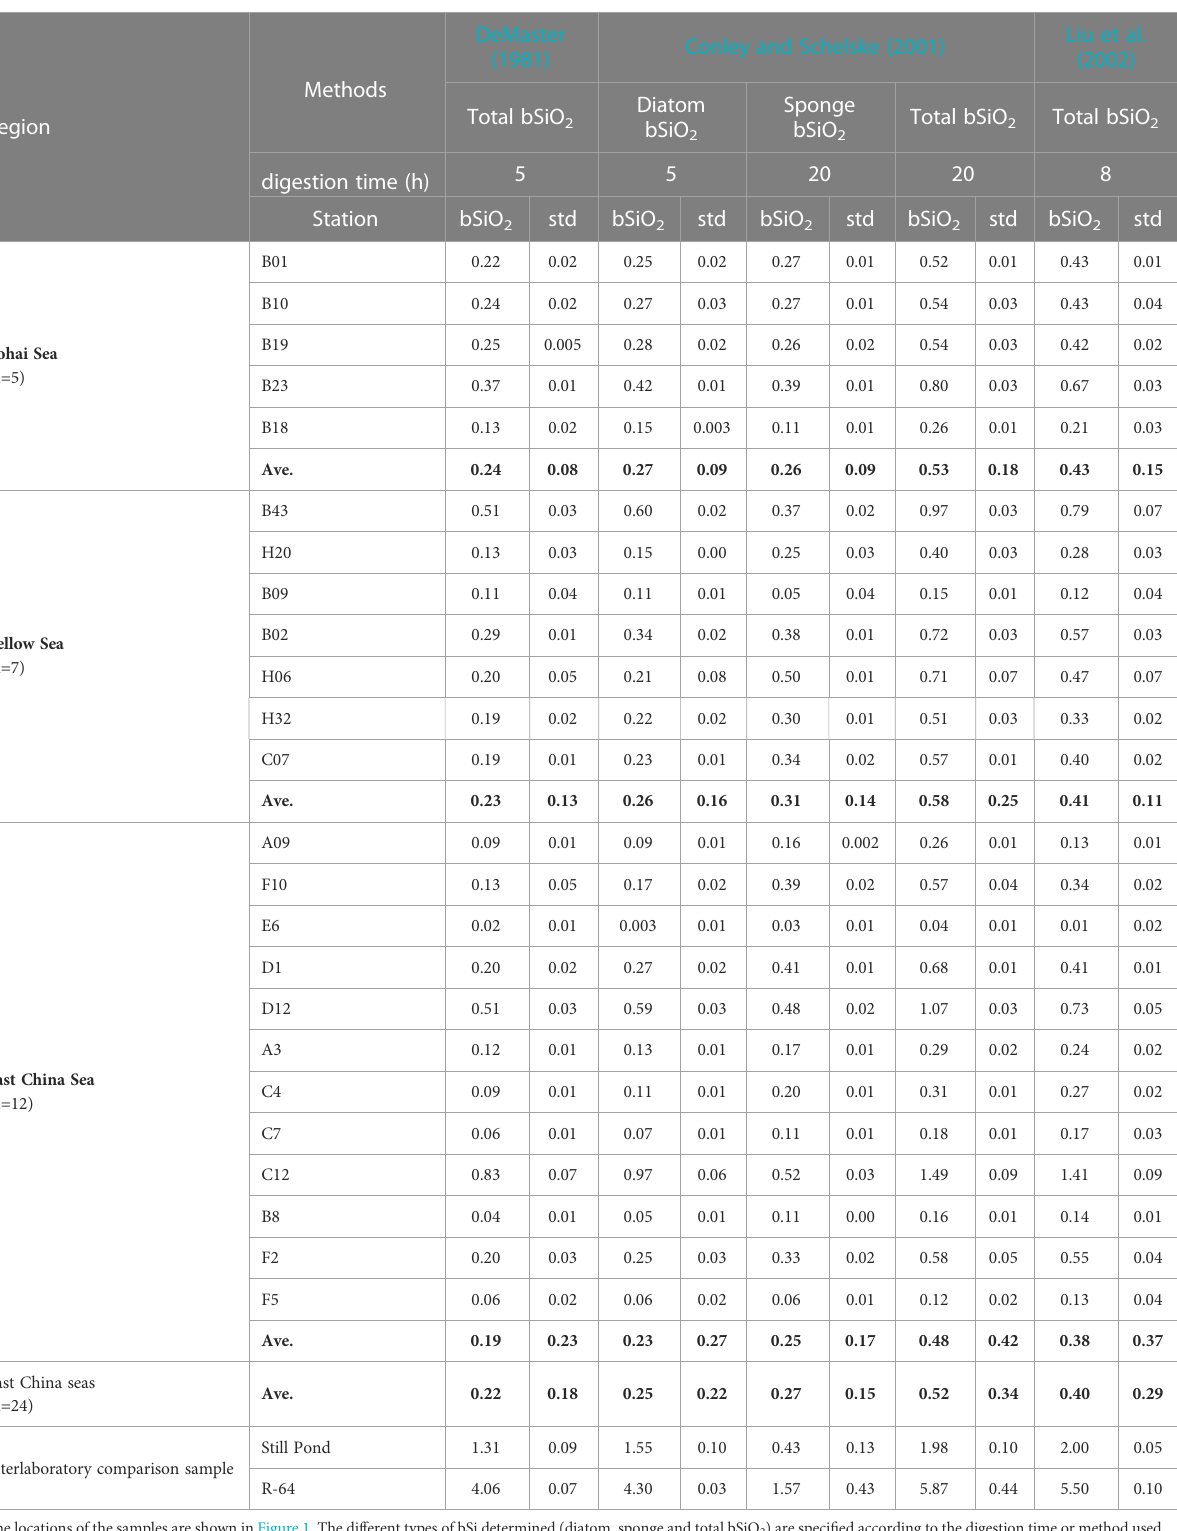
TABLE 4 The bSiO 2 % in sediments of the East China seas (BH, YS, ECS) was determined using the Si/time alkaline digestion method (0.1 M Na 2 CO 3 ; NP).